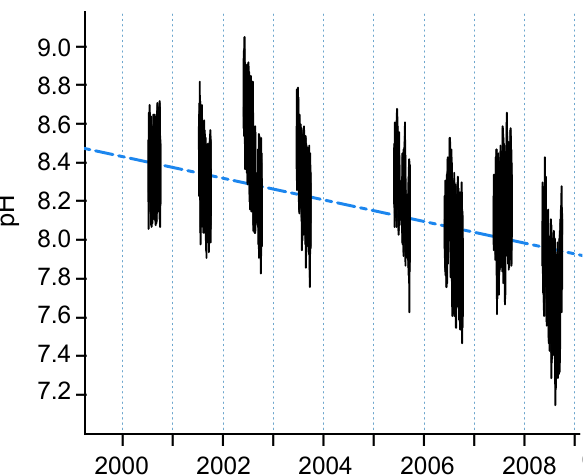
Fig. 5. Plot of pH data measured every 30 min from Tatoosh Island, WA (updated from Wootton et al., 2008). Dashed blue line shows statistically significant decline (highly significant, p = 2 . 2 e − 16).